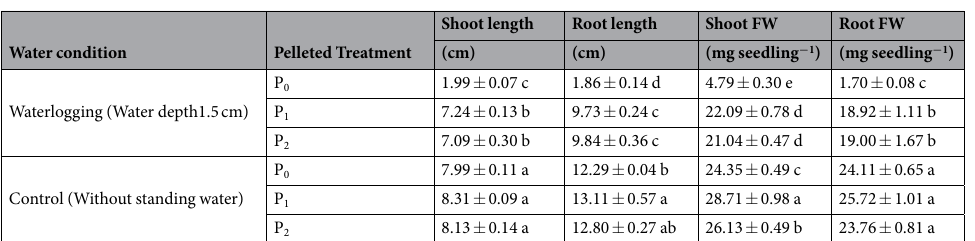
Table 4. The effect of two seed pelleting treatments on seedling growth parameters of direct-seeded rice under waterlogging (1.5 cm water layer) and normal (without standing water) conditions at 8 DAS in Experiment 3. Within a column under each water condition, means followed by different letters are significantly different at a 0.05 probability level according to a least significant difference (LSD) test. P 0 : non-pelleted naked seeds; P 1 : Seed pelleting time of three with CaO 2 content of 20% in formula 1; P 2 : Seed pelleting time of three with CaO 2 content of 20% in formula 2. FW: fresh